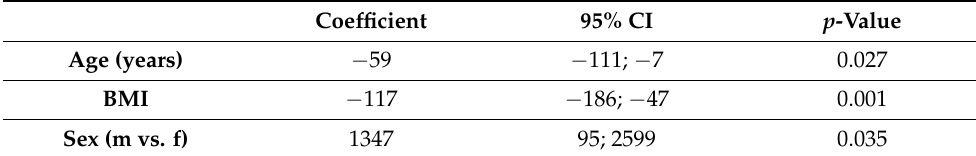
Figure 2. Daily steps of the three groups: 1 = BMI <30, 2 = BMI 30–34.9, 3 = BMI > = 35. Table 4. Linear regression analysis; CI = confidence interval.